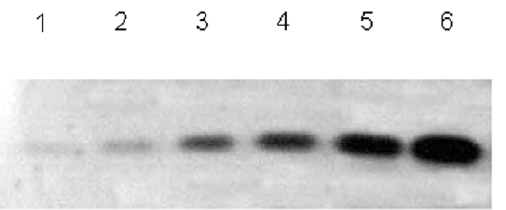
Figure 3. Gels stained at different time periods. BSA (500 ng) was separated by SDS-PAGE and stained with water-soluble CBBR solution at boiling temperature for 30 s (Lane 1), 60 s (Lane 2), and 120 s (Lane 3) and at room temperature for 1 h (Lane 4), 6 h (Lane 5), 14 h (Lane 6), and 24 h (Lane 7).